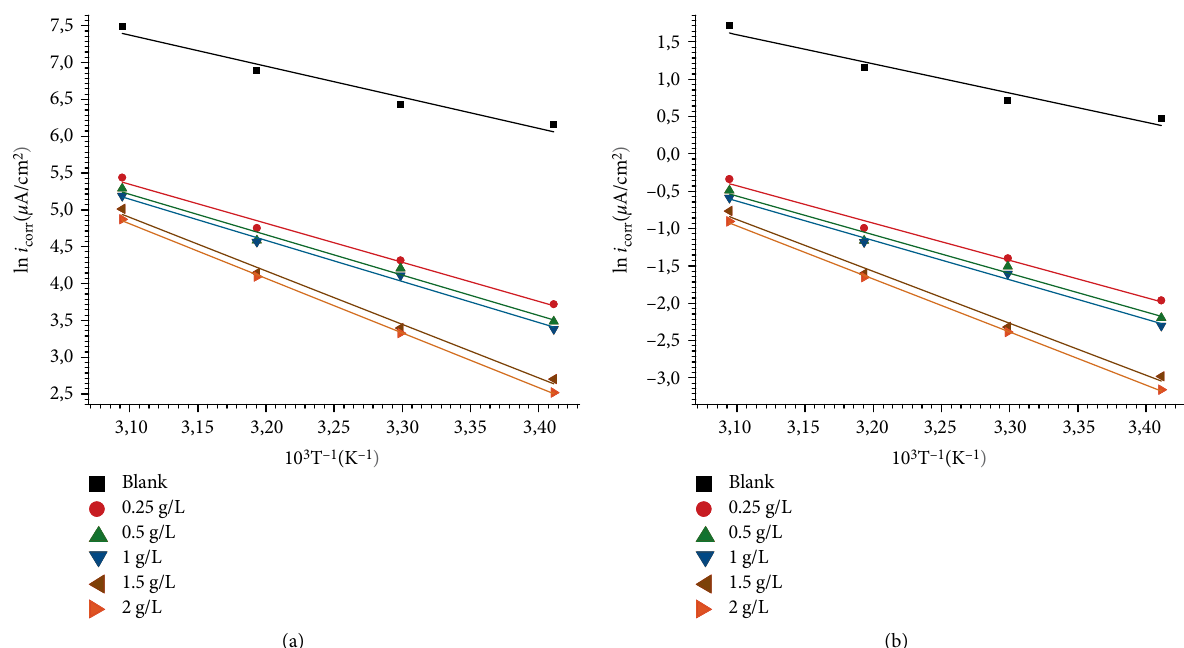
Figure 8: (a) Arrhenius plots, (b) transition state plots for C38 steel in 1 M HCl without and with different concentration of HECG.